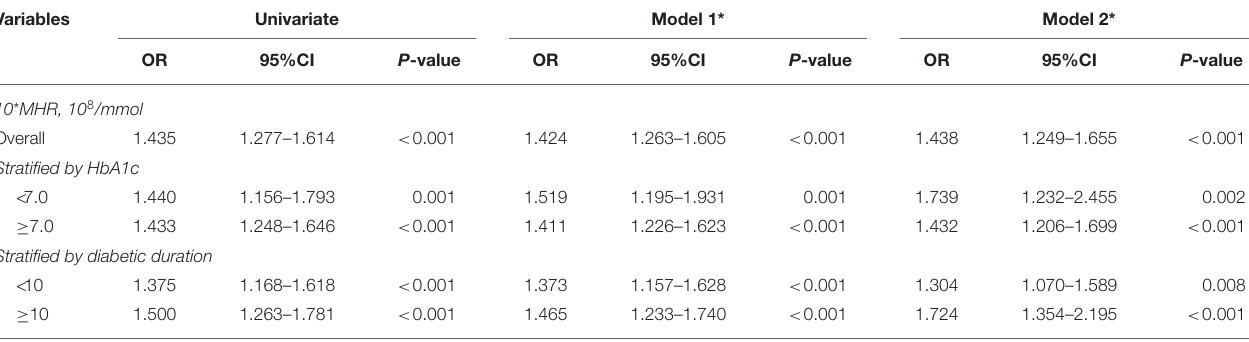
TABLE 2 | Logistic regression analysis assessing the association of the MHR with diabetic retinopathy. Variables Univariate Model 1* Model 2* OR 95%CI P -value OR 95%CI P -value OR 95%CI P